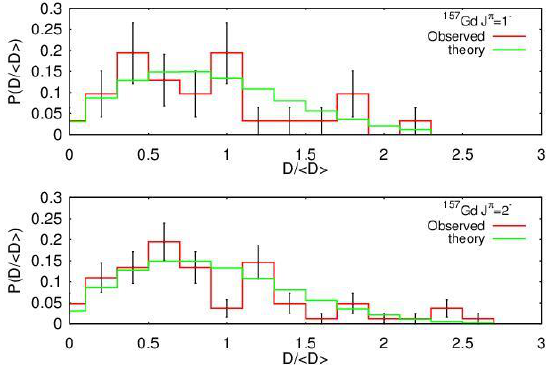
Fig. 7. Wigner distribution (theory) of the resonances spacing in the energy 0 eV to 500 eV for 157 Gd.